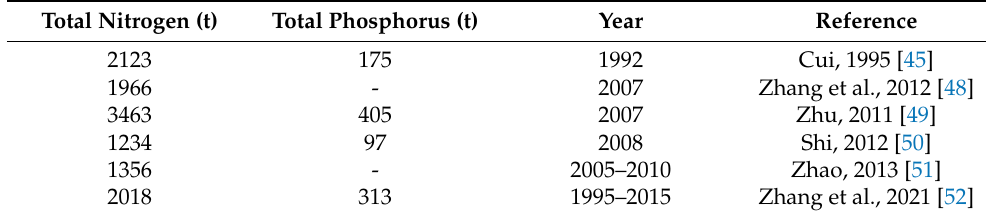
Table 6. The comparison of total pollutants load entering Baiyangdian